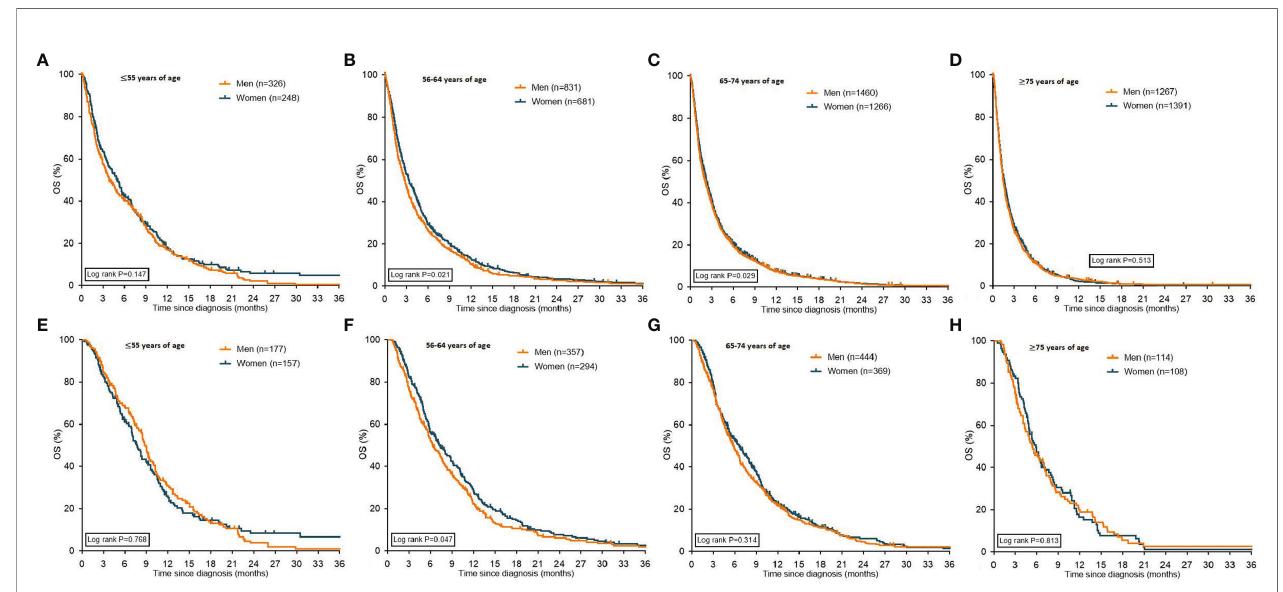
FIGURE 3 | Kaplan Meier curves displaying overall survival in patients with metastatic pancreatic cancer strati fi ed for sex. Graphs (A – D) depict all patients with pancreatic cancer strati fi ed for sex, graphs (E – H) depict patients with pancreatic cancer who received systemic treatment strati fi ed for sex. OS: overall survival